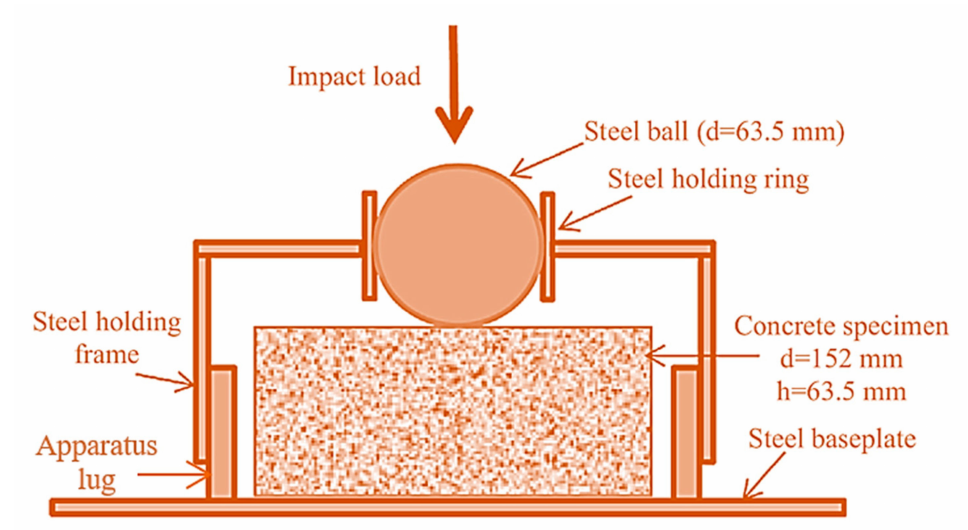
Figure 2. Falling mass impact test apparatus and specimen recommended by the ACI Committee